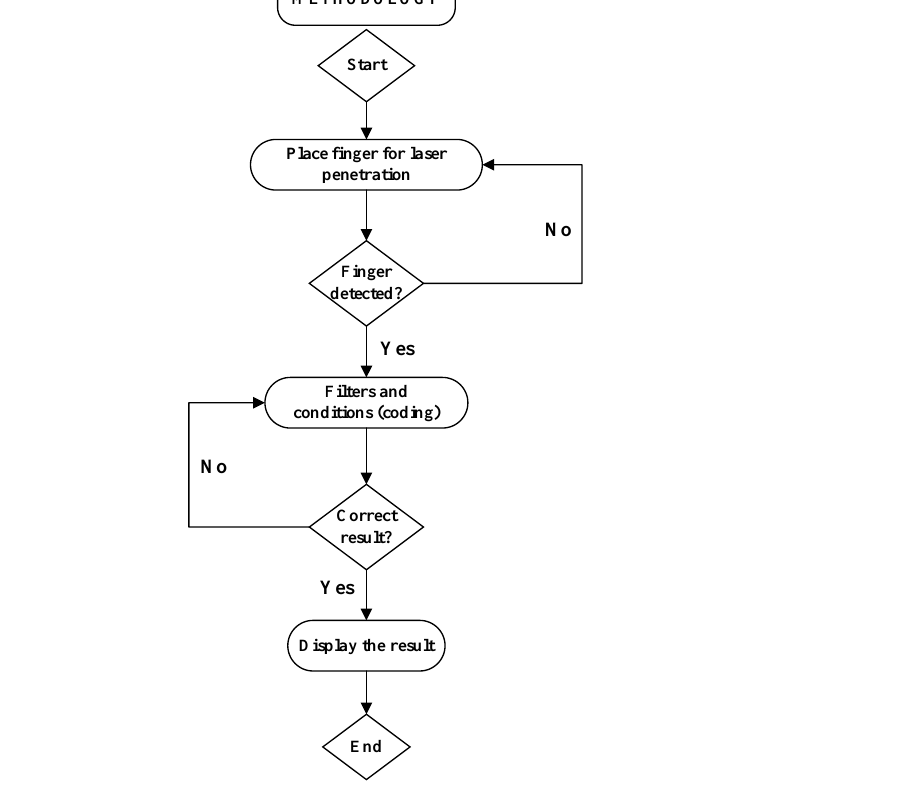
Figure 2. System flowchart, beginning with subjects placing an index finger on the Max30102 sensor. If their index finger is detected, the system will run filters and conditions in Arduino code. If the results match the filters and conditions, they will be displayed on the Oled display screen.